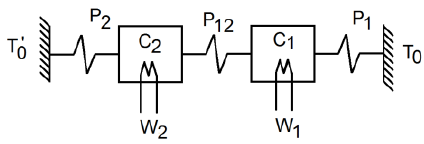
Figure 5. Calorimetry sensor model: C 1 represents the power dissipation element and one surface of the measurement thermopile, C 2 represents the thermostat and the thermopile’s other surface. T 0 and T′ 0 represent temperatures outside the sensor. W 1 and W 2 are the powers dissipated in each domain.